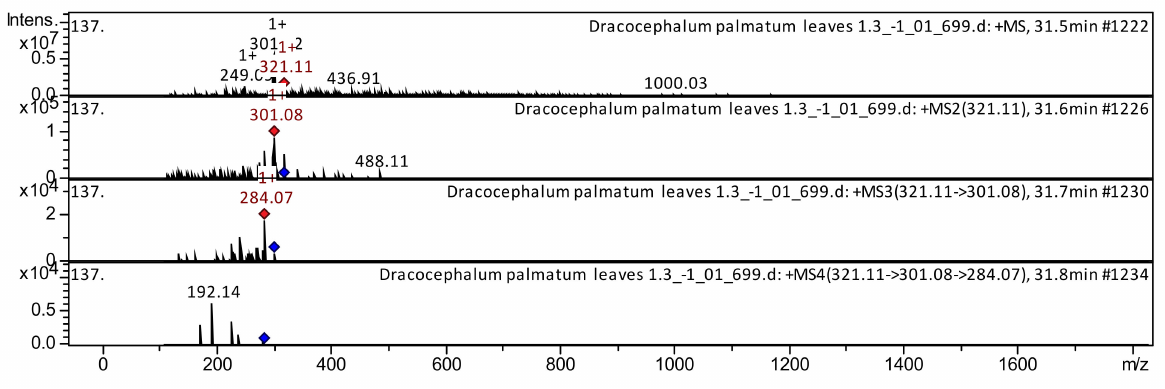
Figure 8. CID spectrum of ampelopsin from extracts of D. palmatum , m / z